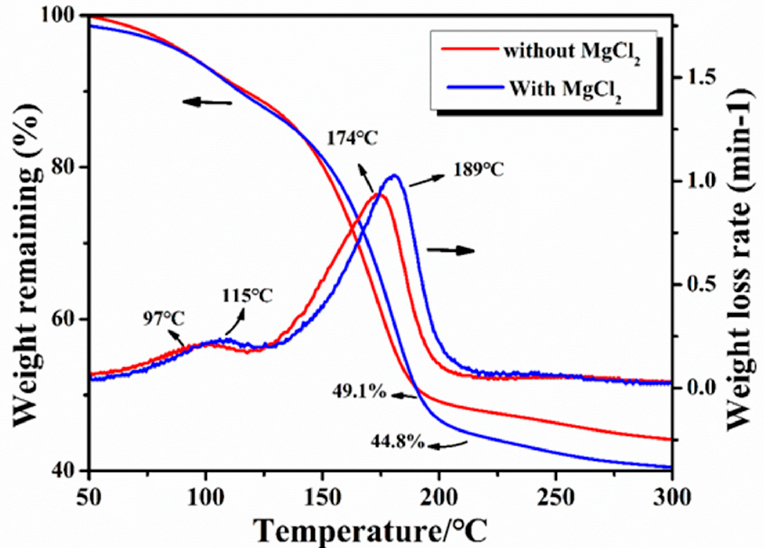
Figure 4. TG curves of the resin mixtures with and without MgCl 2.